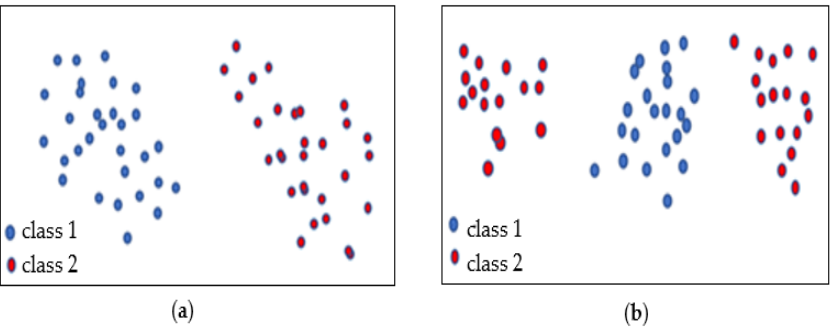
Figure 2. Linear and non-linear classification ( a ) linear classification of the data distribution; ( b ) combine the algorithm with clustering arises.